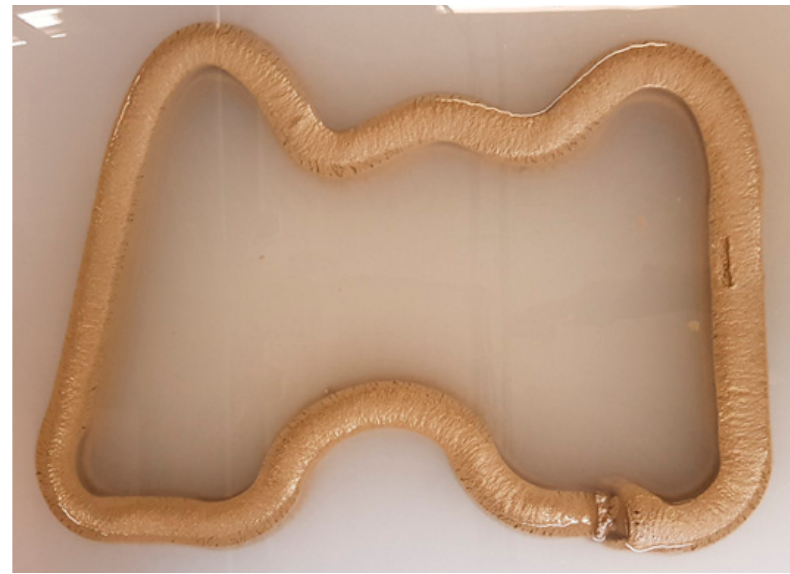
Figure 20. Result of curved shape underwater printing.